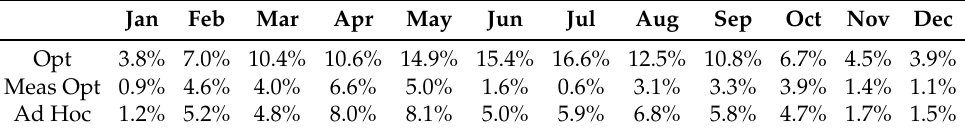
Table 10. Monthly PV self-consumption improvement for a single building.